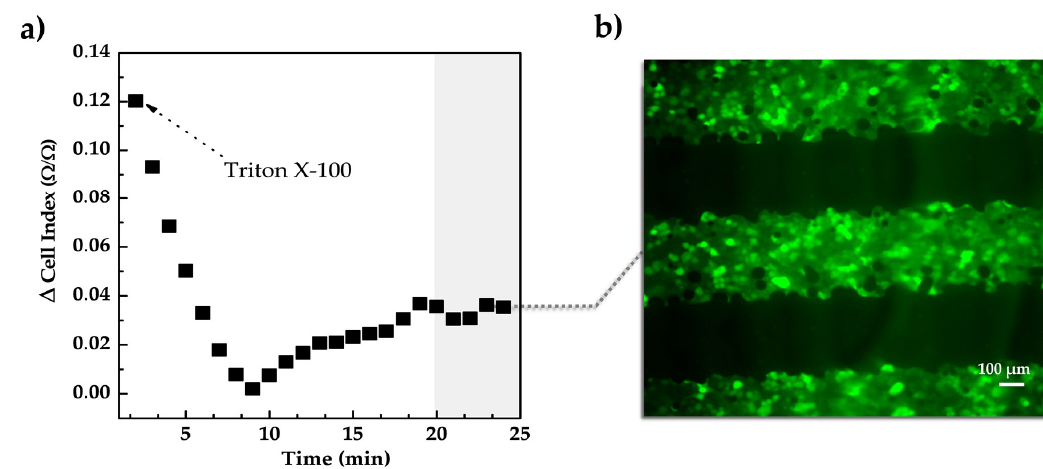
Figure 6. ( a ) Monitoring the addition of chemicals by impedance spectroscopy. Triton X-100 was added to the cell culture to destroy the bi-lipid membrane of the cells. The impedance drastically dropped in the first 10 min after the addition of the chemical. ( b ) Optically observation of the presence of cells under the sensors after 20 min of adding Triton